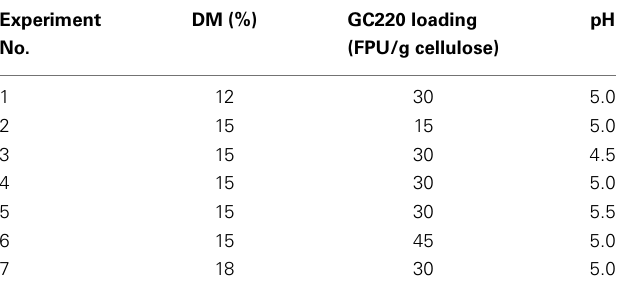
Table 1 | Operating parameters (DM, cellulase loading, and pH) for the SSF experiments .